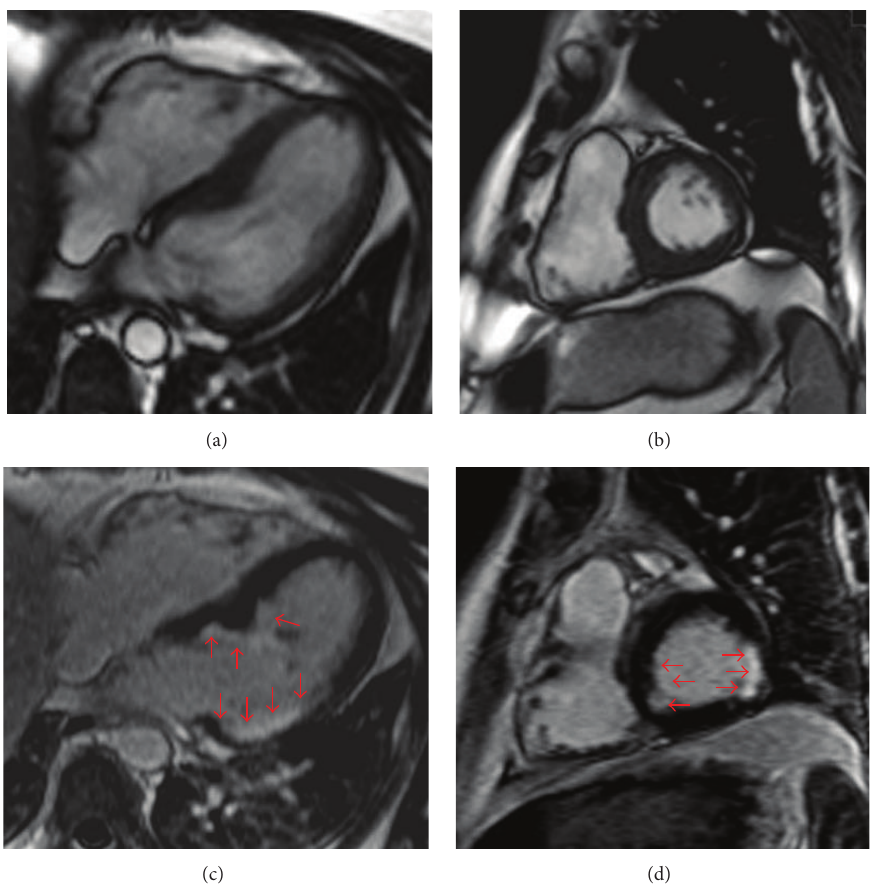
Figure 2: Cardiac magnetic resonance. Cine images in four-chamber long-axis view (a) and short-axis view (b). Late gadolinium enhance- ment (LGE) images in four-chamber long-axis view (c) and in short-axis view (d). Arrows point to regions of increased signal intensity, indicating focal fibrosis, visible as subendocardial